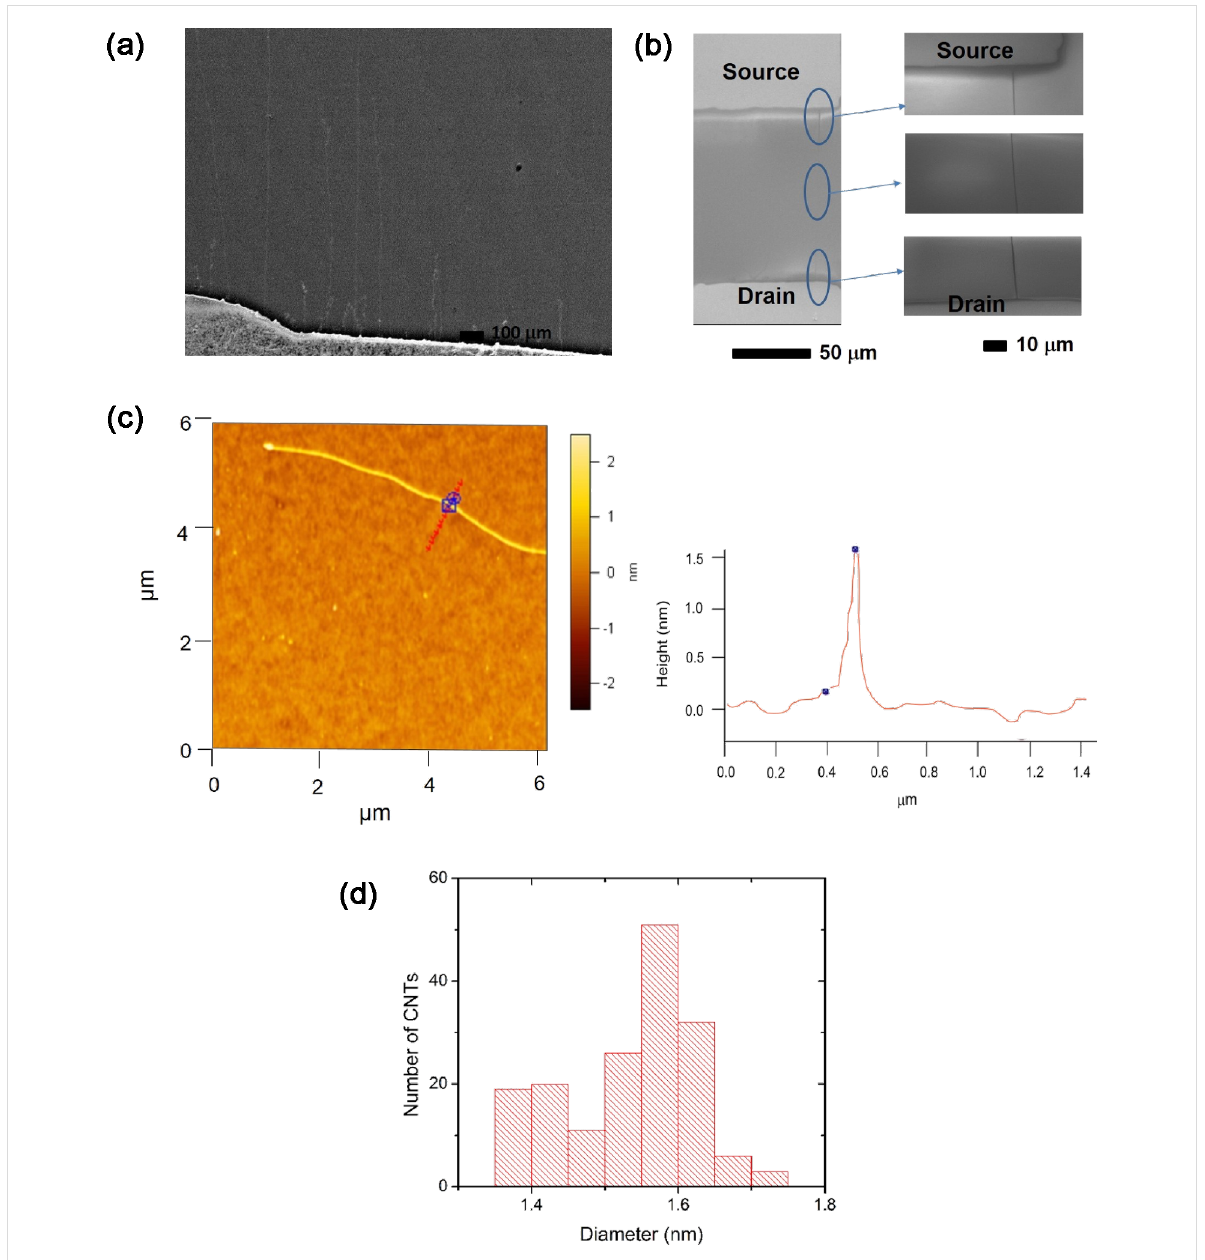
Figure 1: FE-SEM image of (a) CVD grown SWCNTs and (b) a SWCNT FET with an enlarged view of the SWCNT near the source, central and drain regions. (c) AFM image of a single SWCNT and its height profile indicating the SWCNT diameter is ≈ 1.51 nm. (d) Histogram plot showing the diameter distribution of the SWCNTs. The average diameter of the SWCNTs was ≈ 1.53